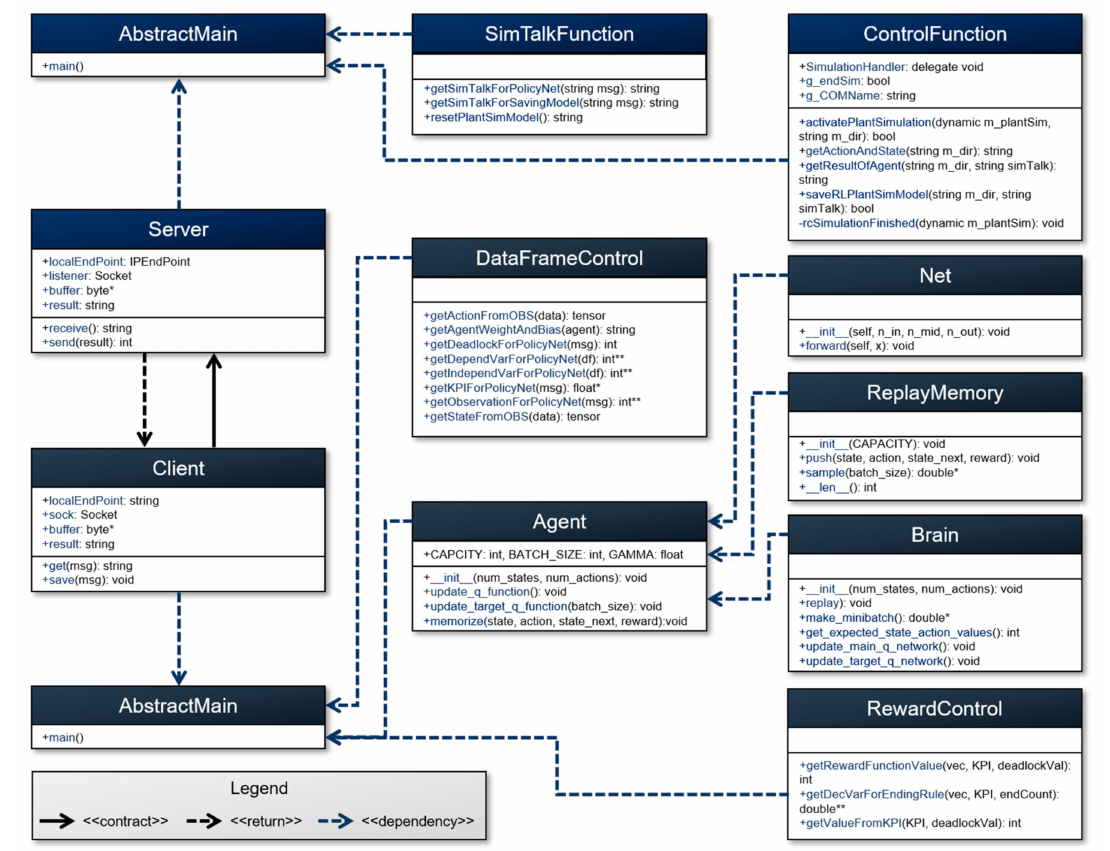
Figure 9. Simulation model and DRL-integrated module class